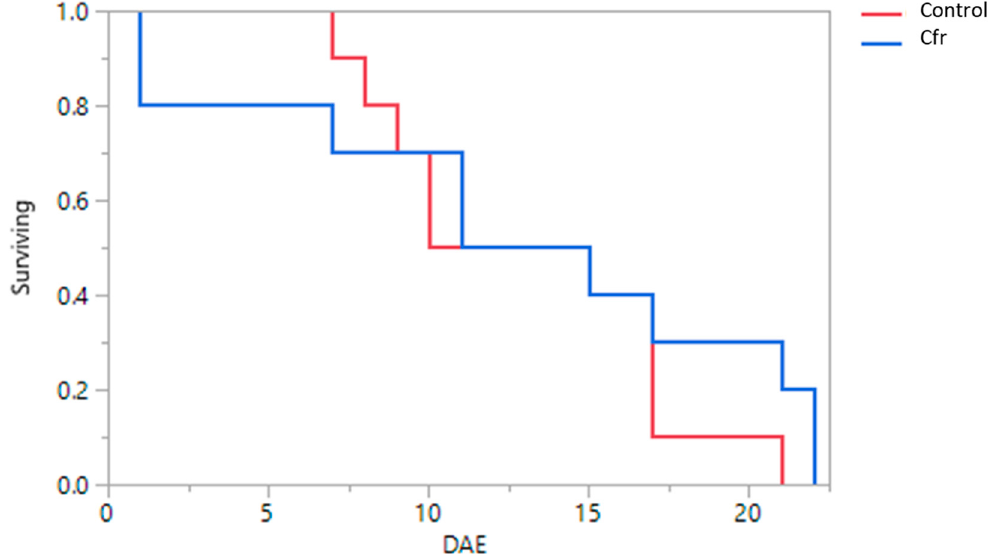
Figure 4. Survival curves of adult Delphastus catalinae beetle days after exposure (DAE) to Aleurothrixus trachoides eggs treated with either Cordyceps fumosorosea (Cfr) or water (control) on leaves of Red Missile ornamental plants for 24 h. Fresh untreated eggs were provided to the beetles every 3 days after the 24 h exposure period for 21 days. The median survival times of the adult beetles were not significantly different between treatments (log-rank test, p > 0.05).